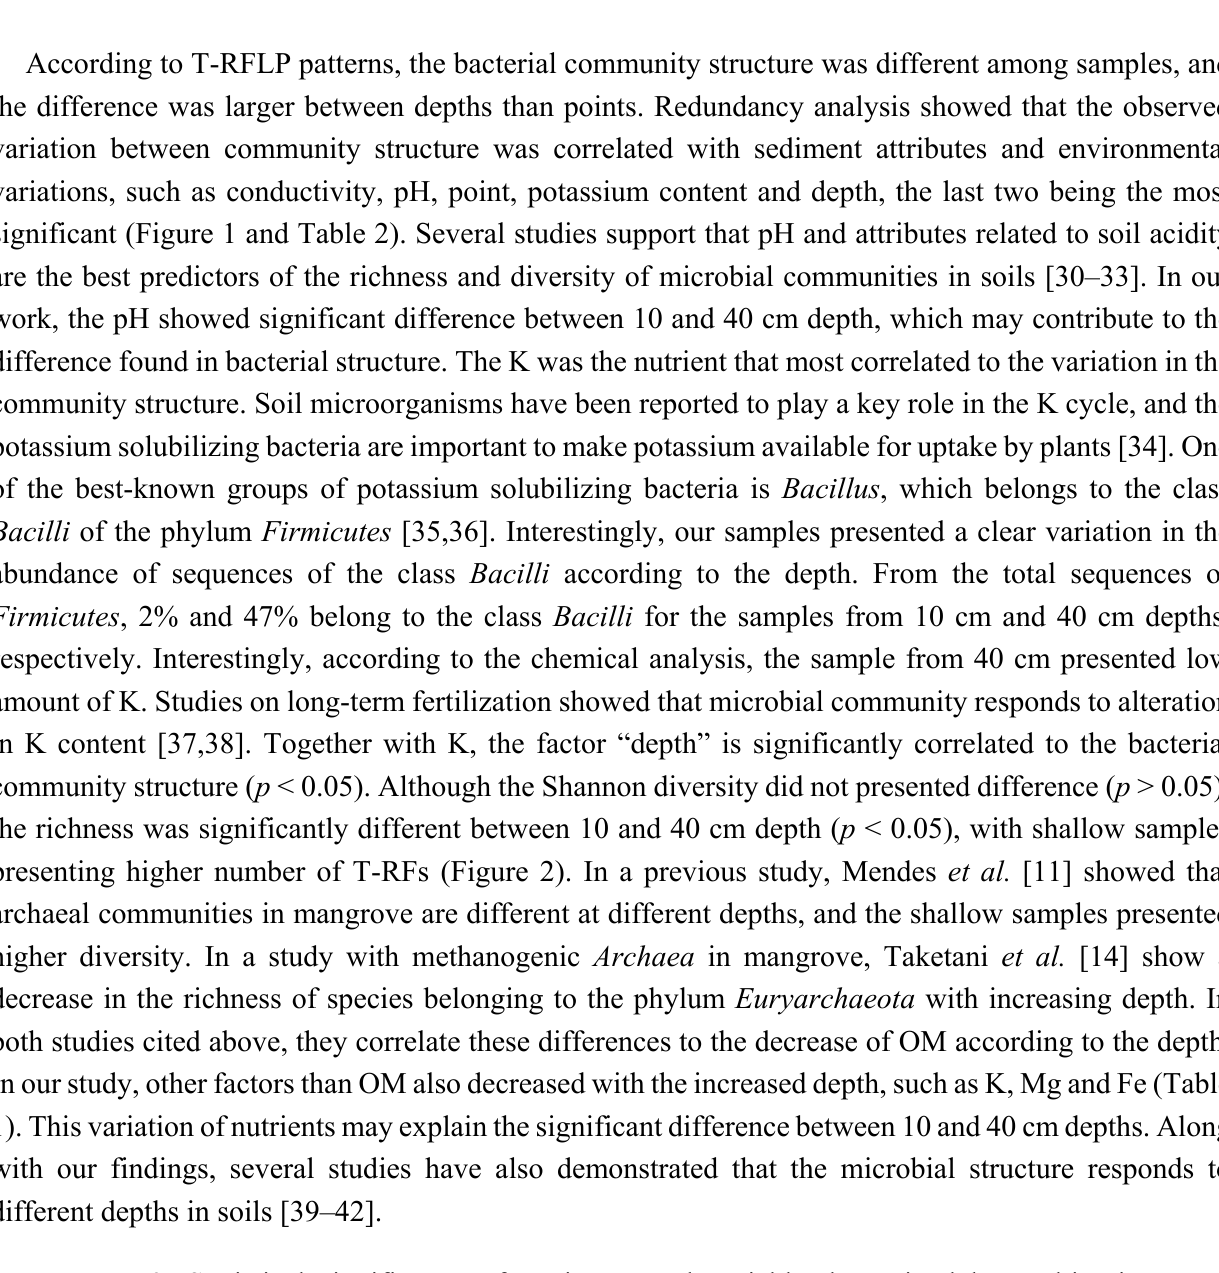
Table 2. Statistical significance of environmental variable determined by multivariate analysis based on the redundancy methodology